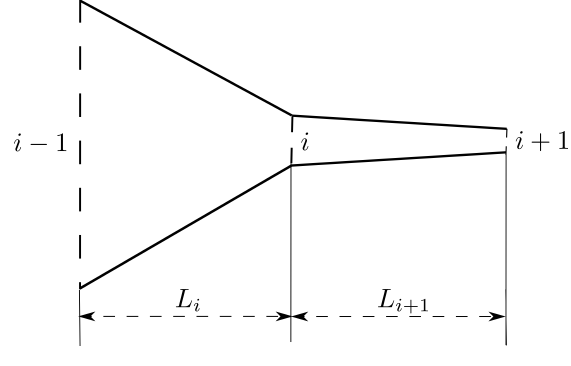
Figure 5. Schematic of discretized cross sections. Table 2. Extracted input